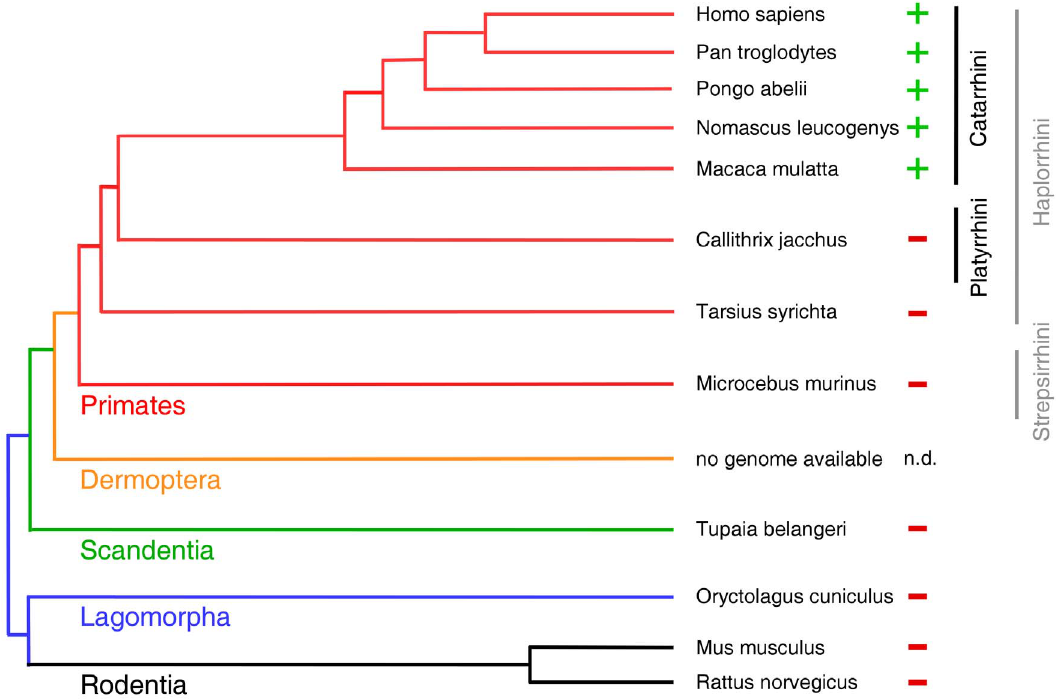
Figure 2. The molecular chaperone Hsp103 is specific to higher primates. The supraorder Euarchontoglires comprises the orders Primates, Dermoptera, Scandentia, Lagomorpha and Rodentia. This illustration shows the relationship of the species which we analyzed for Hsp103 E domain sequences. The figure is a simplified re-drawing from the comprehensive phylogenetic trees generated by Janecka et al. [22] and Perelman et al. [23], limited to the 12 species shown. The presence or absence the extra E domain sequence in the respective species is indicated by + or –. It turned out that the extra domain of Hsp103 is only present in the genome of Catarrhini, a primate suborder that contains the old world monkeys, great apes and man. Genomic data for the order Dermoptera were not available (n.d.). E domain specific sequences were detected by BLAST searches as described in Materials and Methods for Nomascus leucogenys under NCBI XP_003276214; for Pan troglodytes under NCBI NW_003457860.1 (regions from base 6775968 to 6776180 and from 6814113 to 6814267, matching exon2 and exon1); for Pongo abelii under NCBI NW_002887407.1 (regions from base 9860 to 10072 and from 50476 to 50631) and for Macaca mulatta under NCBI NW_001121227.1 (regions from base 1585406 to 1585618 and from 1619418 to